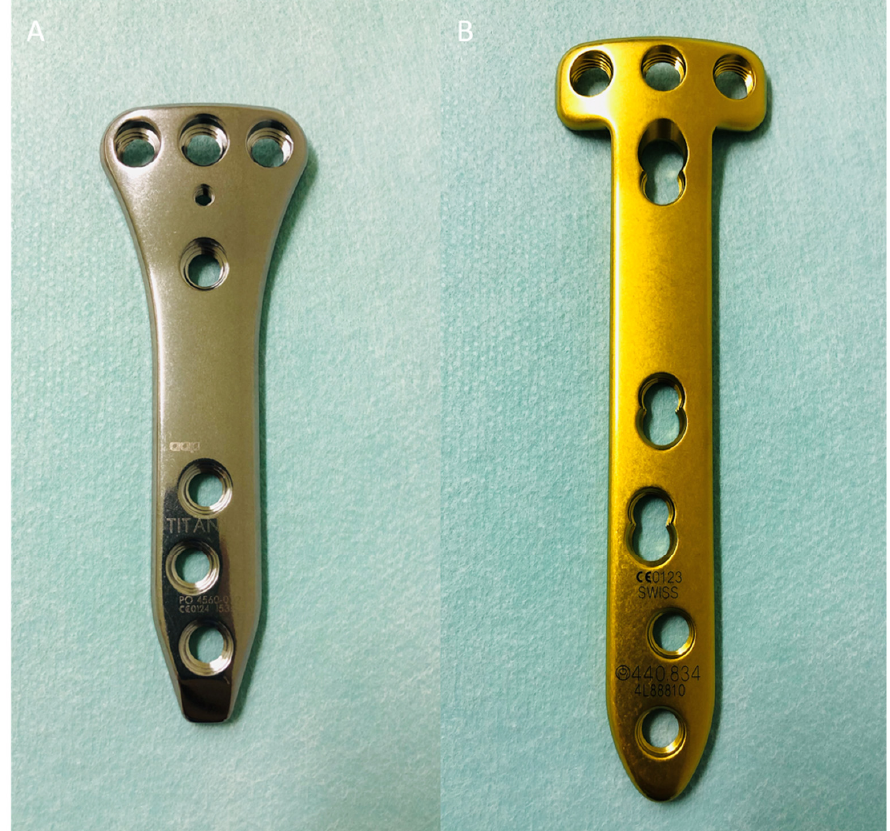
Figure 1. ( A ) LOQTEQ ® HTO plate (aap Implants, Berlin). This osteosynthesis plate is an angular, stable internal plate fixator made of Ti 6 Al 4 V alloy. Absolute plate length is 90 mm. The plate has a trapezoid shape in its proximal third. Locking screw diameter is 4.5 mm. ( B ) TomoFix™ plate (Synthes, Switzerland). This osteosynthesis plate is an angular, stable internal plate fixator made of pure titanium. Absolute plate length is 120–150 mm. In its proximal third, the plate has a T shape. Locking screw diameter is 5.0